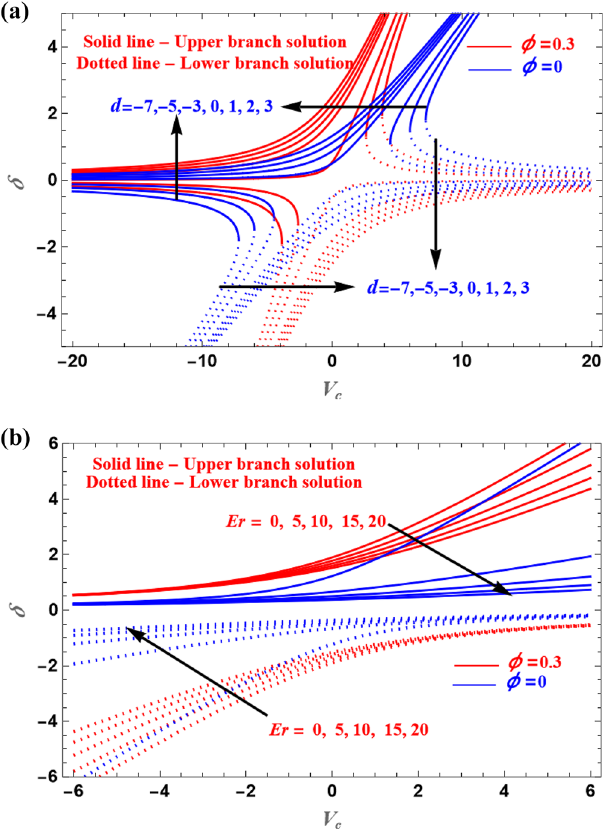
Figure 2. ( a , b ) Illustration of the solution for various values of d and Er